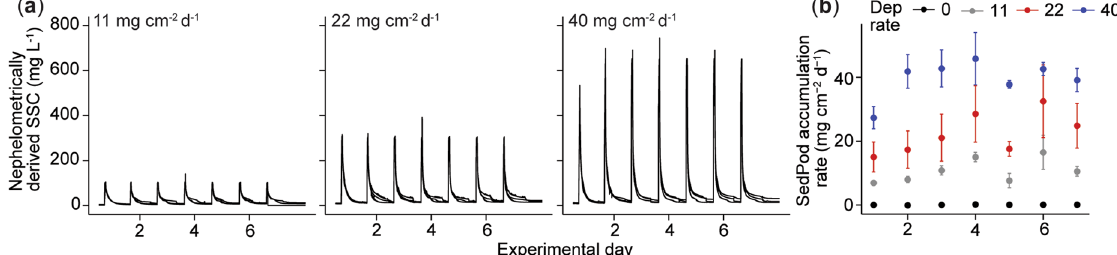
Figure 2. Suspended sediment concentrations (SSCs) and sediment deposition rates in the experimental tanks. ( a ) Nephelometrically-derived suspended sediment concentrations (mg L − 1 ) in each tank for the 7 day exposure period showing resuspension of sediment each afternoon (4:00 pm) followed by a decrease in SSCs as sediment fell out of suspension on the corals and SedPods each night, ( b ) Sedimentation (SedPod accumulation rate, mean ± SE, n = 3) after each of the deposition events across the 4 deposition rate treatments of 0, 11, 22 and 40 mg cm − 2 .